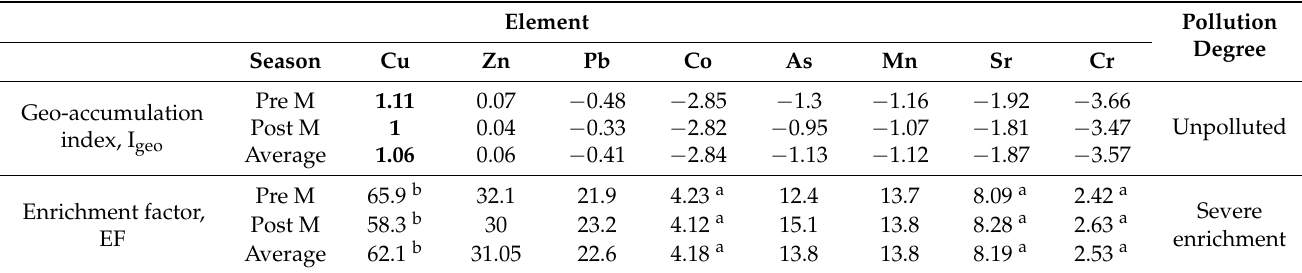
Bold values indicate “Moderately polluted” category; Pre M for pre-monsoon, Post M for post-monsoon. a Minor to moderately severe enrichment, b Extremely severe